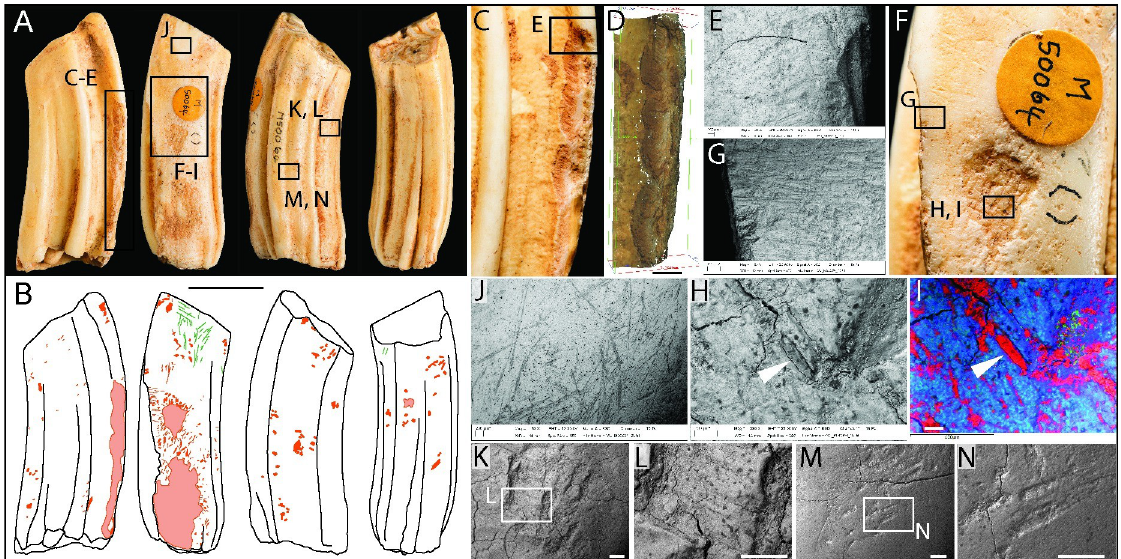
Fig 2. Photographs ( A ) and drawings ( B ) of horse molar M50064, showing knapping damage (pink) and scratches (green) in labial, mesial, lingual, and distal views (Scale = 50 mm). SEM micrographs, Alicona images and macro-photograph detailing: (C-D) chipped enamel along the mesostyle; (E) transverse parallel abrasions associated with flaked enamel; (F) macro-photograph of the working area on the mesial surface, showing minute punctiform features, transverse micro-abrasion and a large depression where the focus of pressure-flaking has abraded the enamel to form a bowl-shaped depression. This area has many pits and scores with two dominant alignments at right angles to each other; (G) detail of transverse micro-striations associated with the areas of concentrated knapping features on the mesial surface; (H) SEM image and (I) EDX element plot highlighting fragments of flint embedded in the enamel. Red = silicon (flint and sediment), blue = calcium (enamel); (J) example of random striations from contact with a stone tool. Although these marks occur over much of the surface of the tooth, they are more easily discernible on approximal wear facet; (K-L) gouge with flaked enamel and internal parallel striations; (M-N) indentations that appear to be compression features or shallow